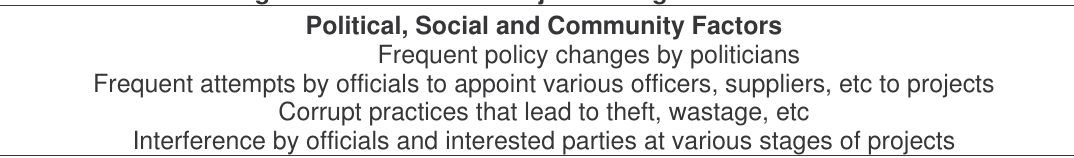
Figure 6: Problems of Project Management in